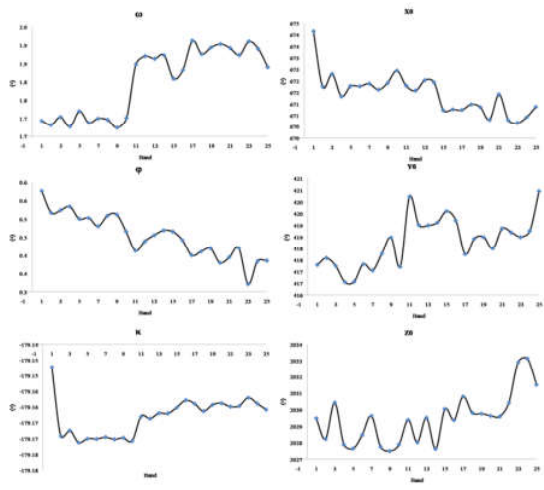
Figure 5. EOPs estimated for the image bands of a single